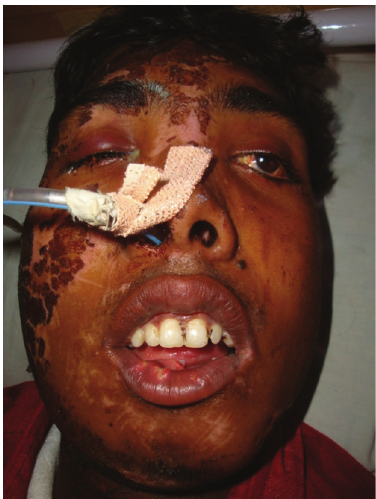
Figure 1: Preoperative.